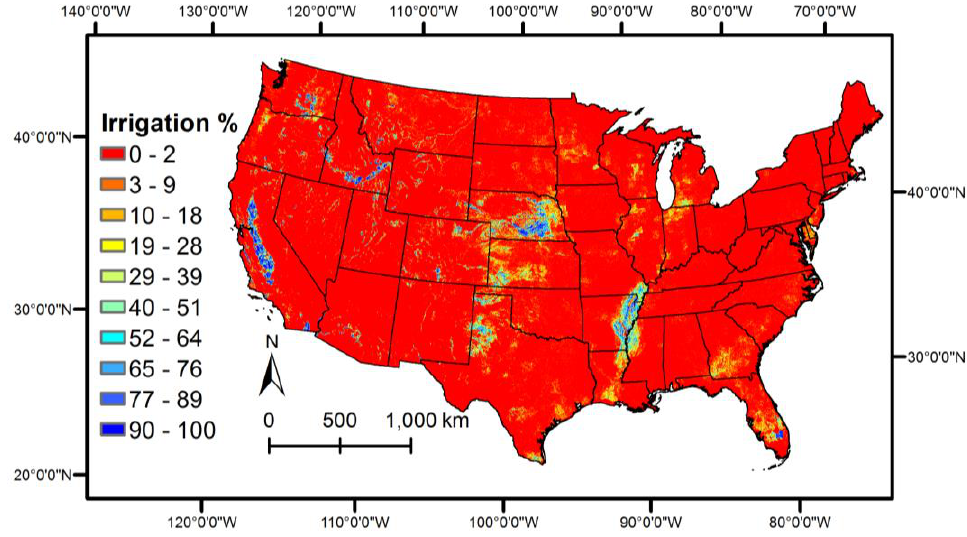
Figure 2. Map of irrigation intensity from the MODIS Irrigated Agriculture Datasets for the United States (MirAD-US), averaged over datasets from 2002, 2007, and 2012 [27].